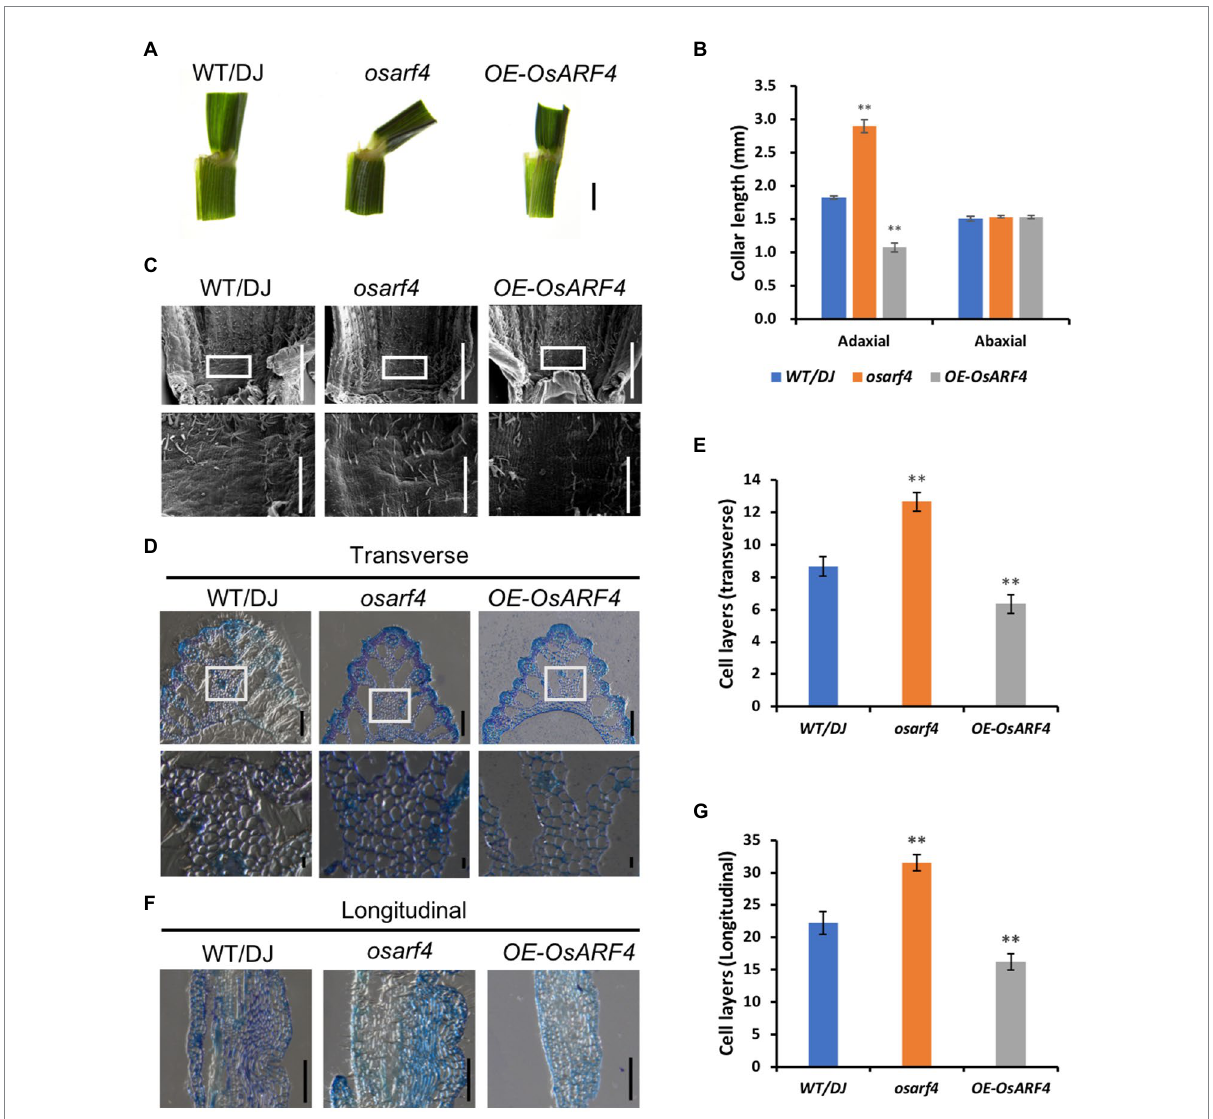
FIGURE 3 Microstructure analysis of LJs in WT/DJ, osarf4 mutants, and OsARF4- overexpressing lines. (A) Comparison of LJs of flag leaves in 3-month-old seedlings of WT/DJ, osarf4 mutants, and OsARF4- overexpressing lines. (B) The collar length of the flag leaves at adaxial and abaxial surfaces in the above-mentioned lines. (C) SEM images of the adaxial surface of the LJ of the flag leaves. (D) Transverse (cross) section of LJs of flag leaves in the above-mentioned lines. Upper panel, bar = 200 μ m; lower panel shows the magnified parts of the upper panel, bar = 20 μ m. (E) Cell layers in transverse sections. Ten biological replicates were considered; ** p < 0.01 represents significant differences using Student’s t -test. (F) Longitudinal section of LJs of flag leaves in the above-mentioned lines. Bar = 200 μ m. (G) Cell layers in longitudinal section of LJs. Ten biological replicates were considered for each test. ** p < 0.01 indicates a significant difference compared with WT/DJ using Student’s t